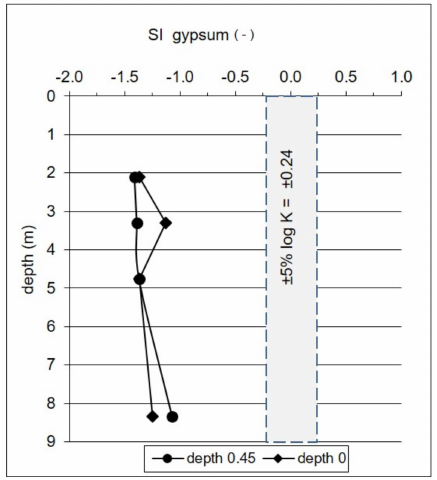
Figure 7. Saturation indices (SI) with respect to gypsum calculated for chemical composition of